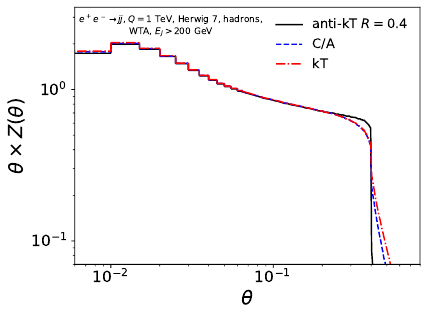
Figure 10 . The jet shape at hadron level as function of angle for the e + e Cambridge/Aachen (blue dashed) and k T algorithm (red